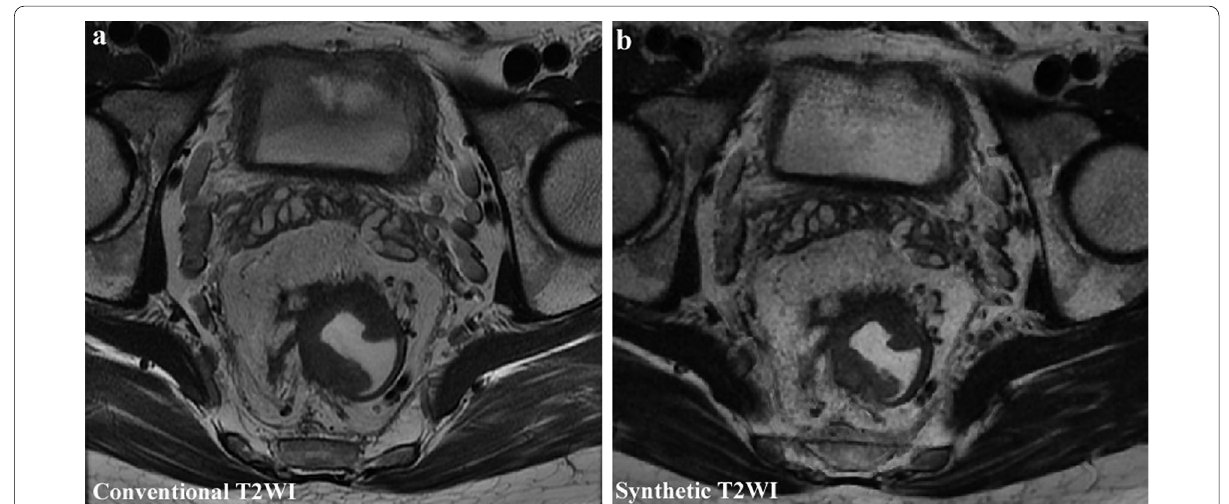
Fig. 4 Conventional and synthetic T2‑weighted imaging (T2WI) from a 46‑year‑old male patient with rectal cancer. Synthetic T2WI provided similar image quality with the conventional T2WI. The patient was evaluated as T3 stage with extramural venous invasion using both conventional T2WI and synthetic